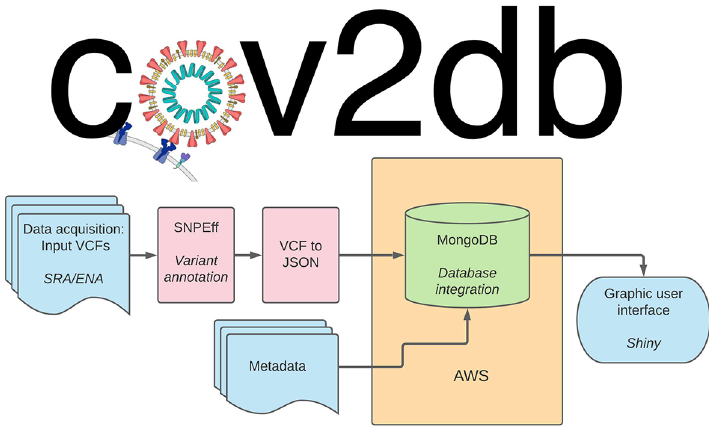
Figure5.Cov2dbworkflowarchitecture. Userprovidedvariantcallformat(VCF)(oriVaroutput)filesareannotated and ultimately converted into JavaScript object notation (JSON). The resulting JSON files serve as the primary